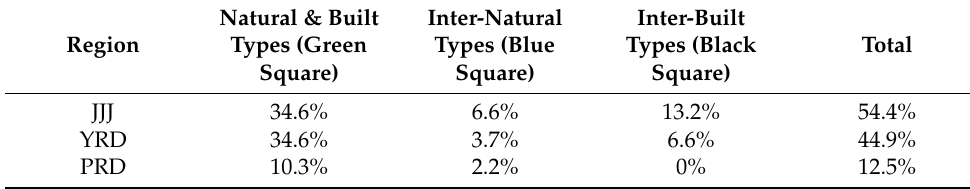
Table 4. Percentage of significant differences between different land covers. Natural & Region Region